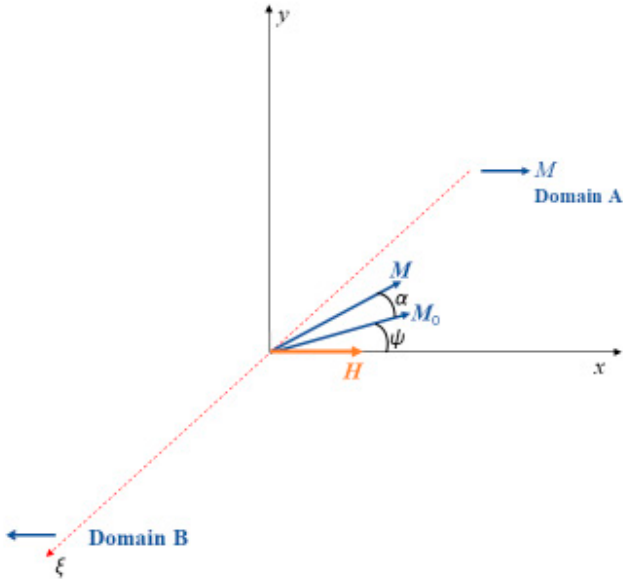
Figure 1. M 0 is the magnetization at H = 0; M is the magnetization in applied field.